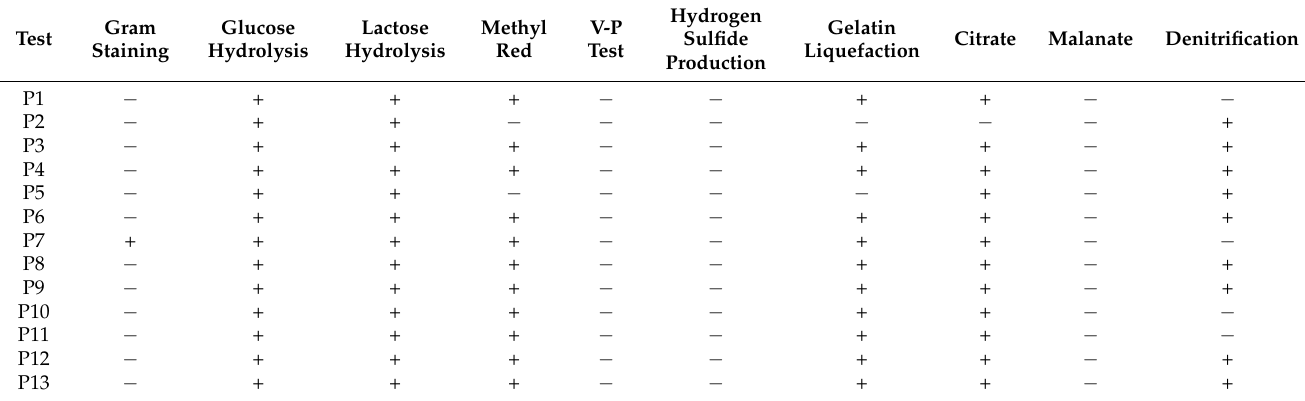
Table 7. Physiological and biochemical features of phosphorus-dissolving bacteria.